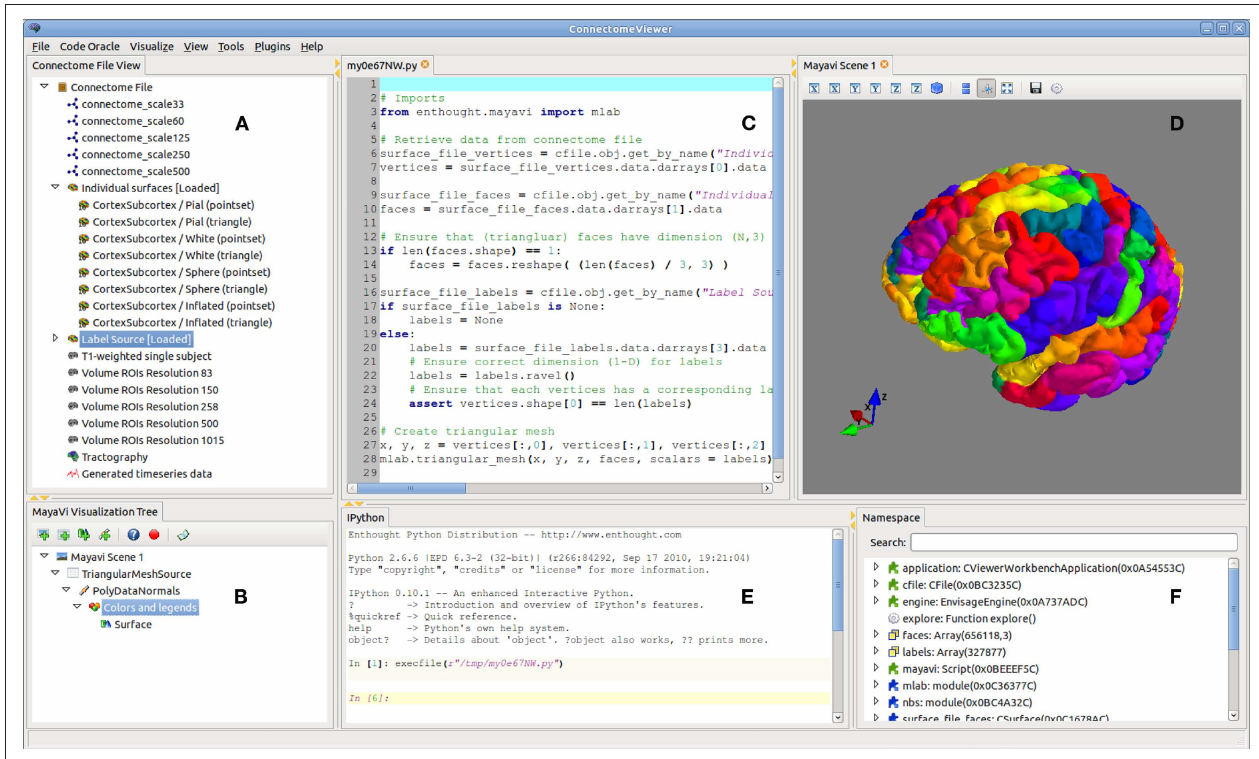
to a medium degree, and red to a high degree. The Connection Matrix Viewer (right). Switching between edge values and highlighting of the edge value ranges is possible. The From and To labels, and edge values are updated automatically when moving over the matrix with the